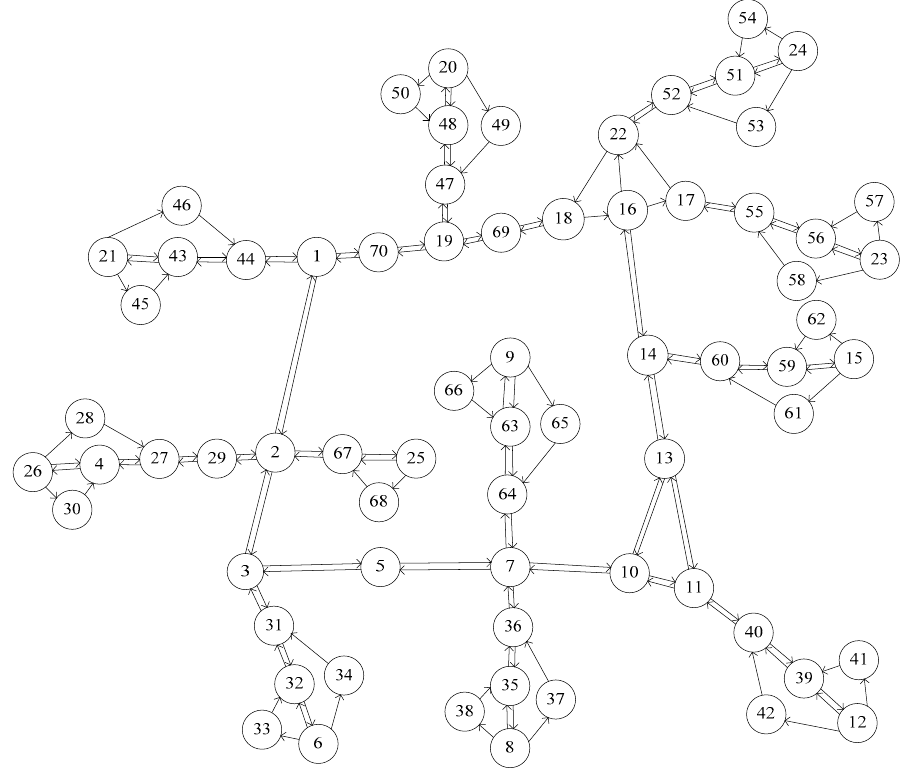
Figure 1. Network from a part of Chennai.